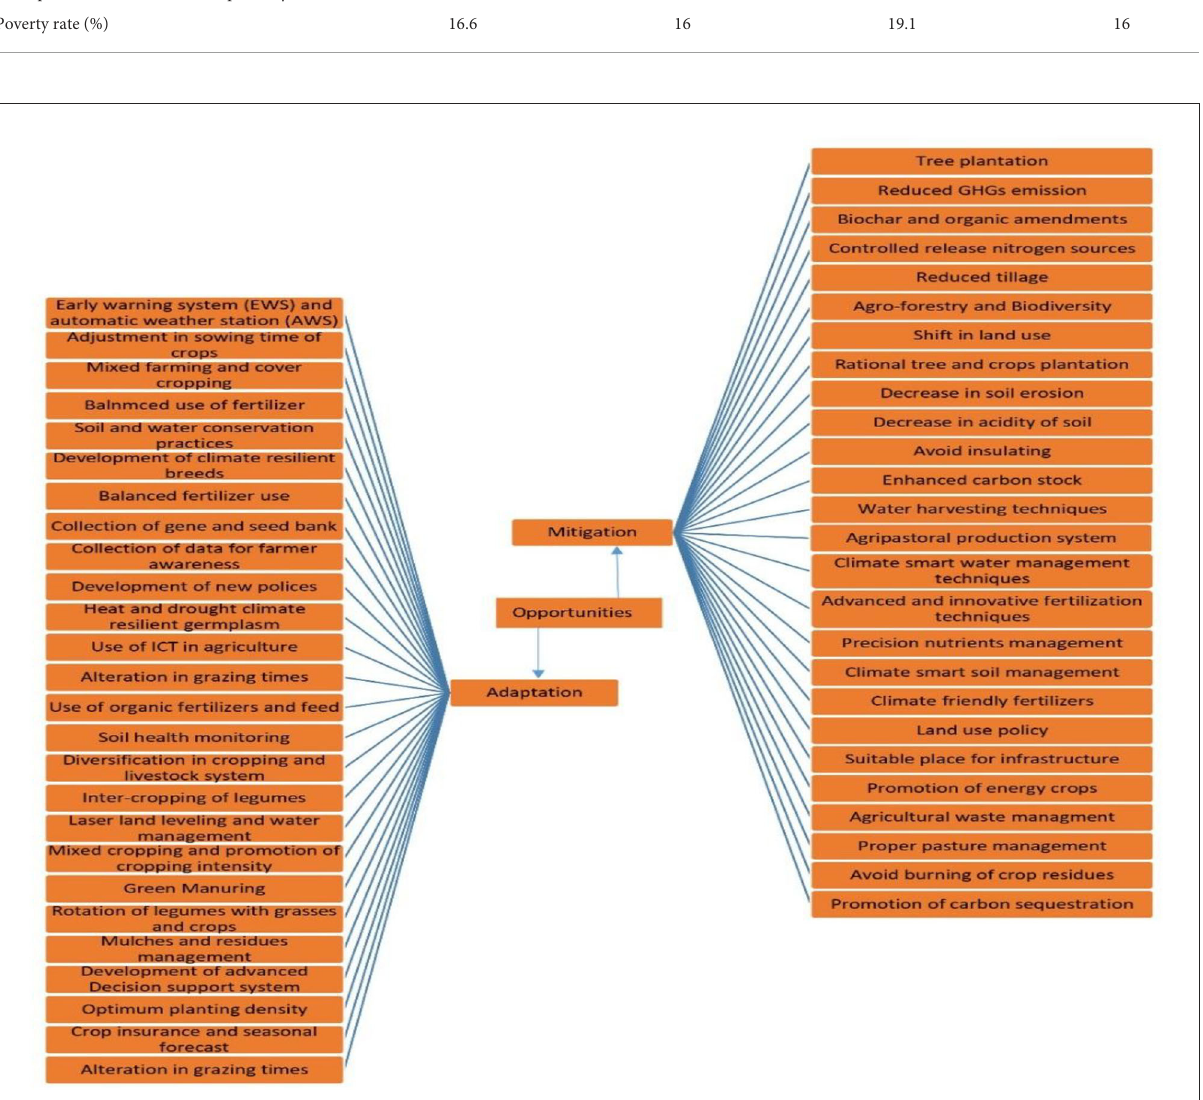
FIGURE10 Overview of opportunities including adaptations and mitigations strategies for sustainable agriculture production system in Asia.